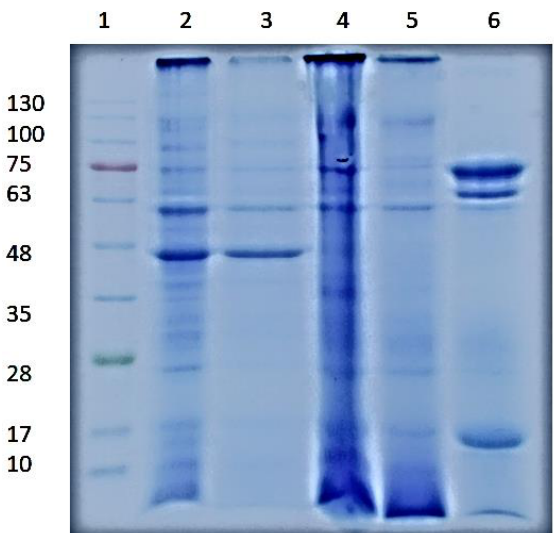
Figure 2. The linearly enhanced (sharpness) electropherogram image of the molecular weight distribution of T. molitor fractions determined by SDS–PAGE (samples from left to right: Lane 1: molecular marker, Lane 2: LM, Lane 3: DF, Lane 4: DF-AIP, Lane 5: DF-ASP, and Lane 6: DF-SSP). Original image is presented in Figure S1.